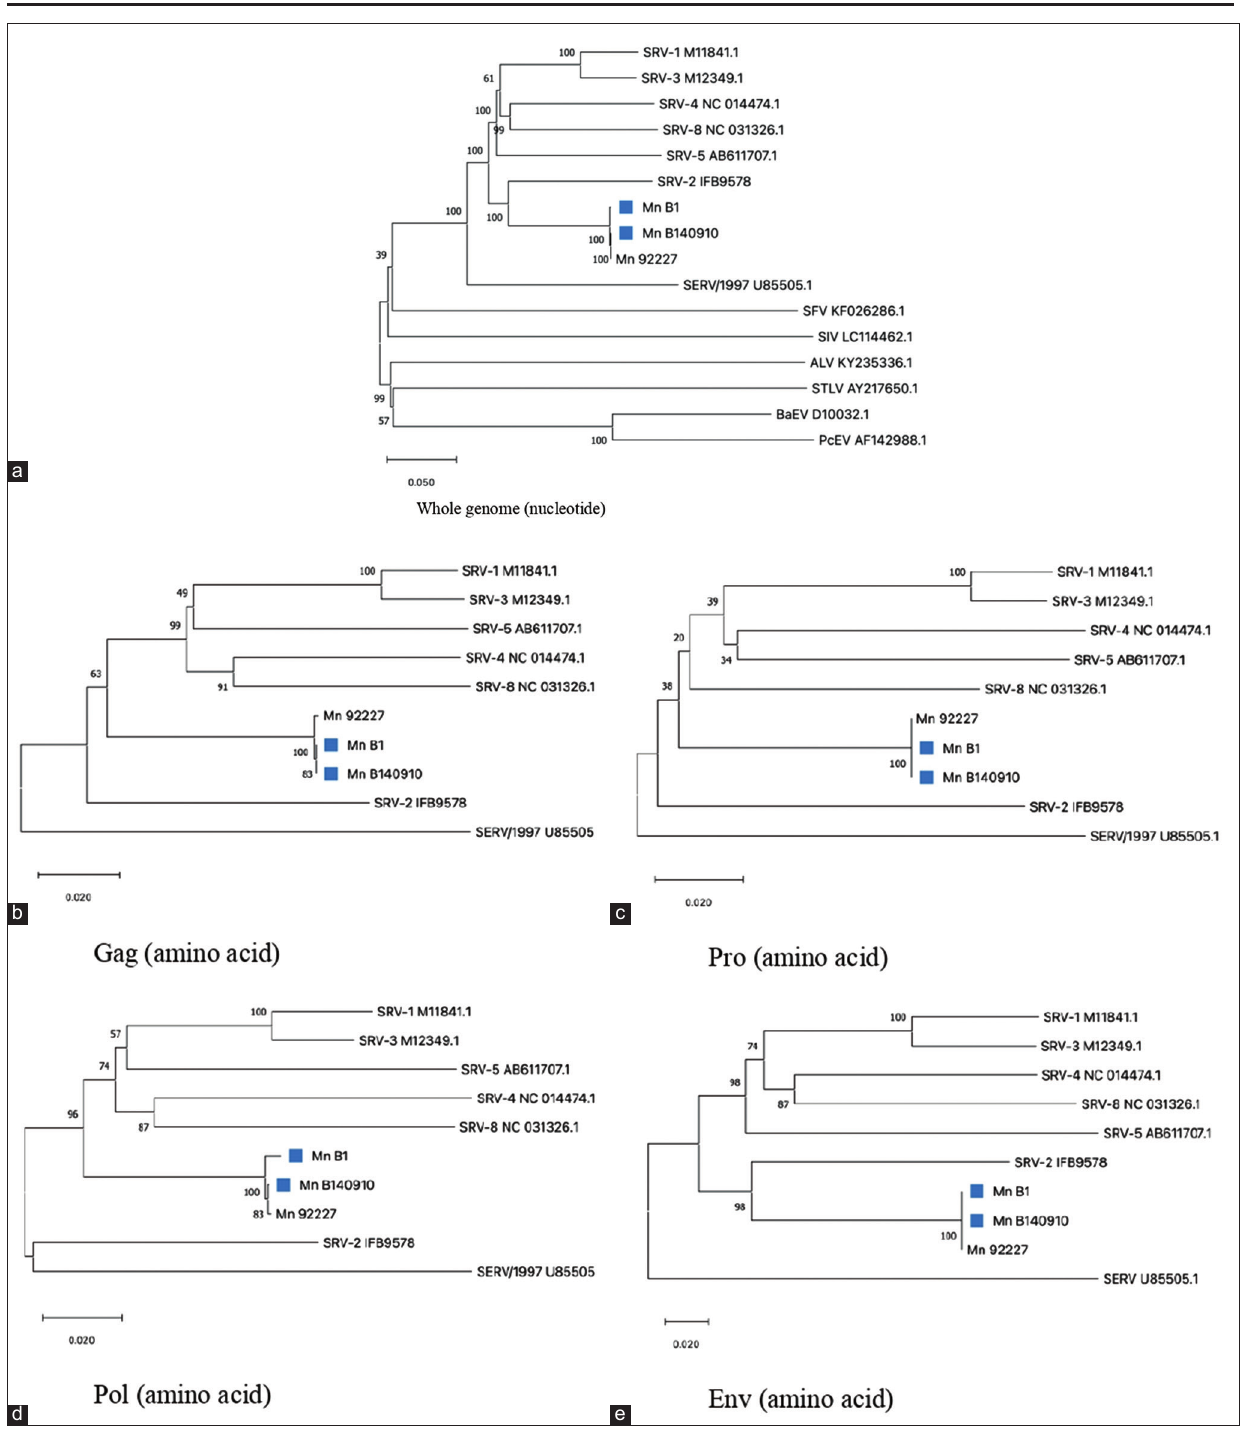
Figure-4: Phylogenetic tree construction of samples against other retroviruses for whole genomes (a); against baboon simian endogenous retroviruses (U85505.1), 92227, simian retroviruses (SRV) 1-5, and SRV-8 for gag amino acid (b), pro amino acid (c), pol amino acid (d), and env amino acid